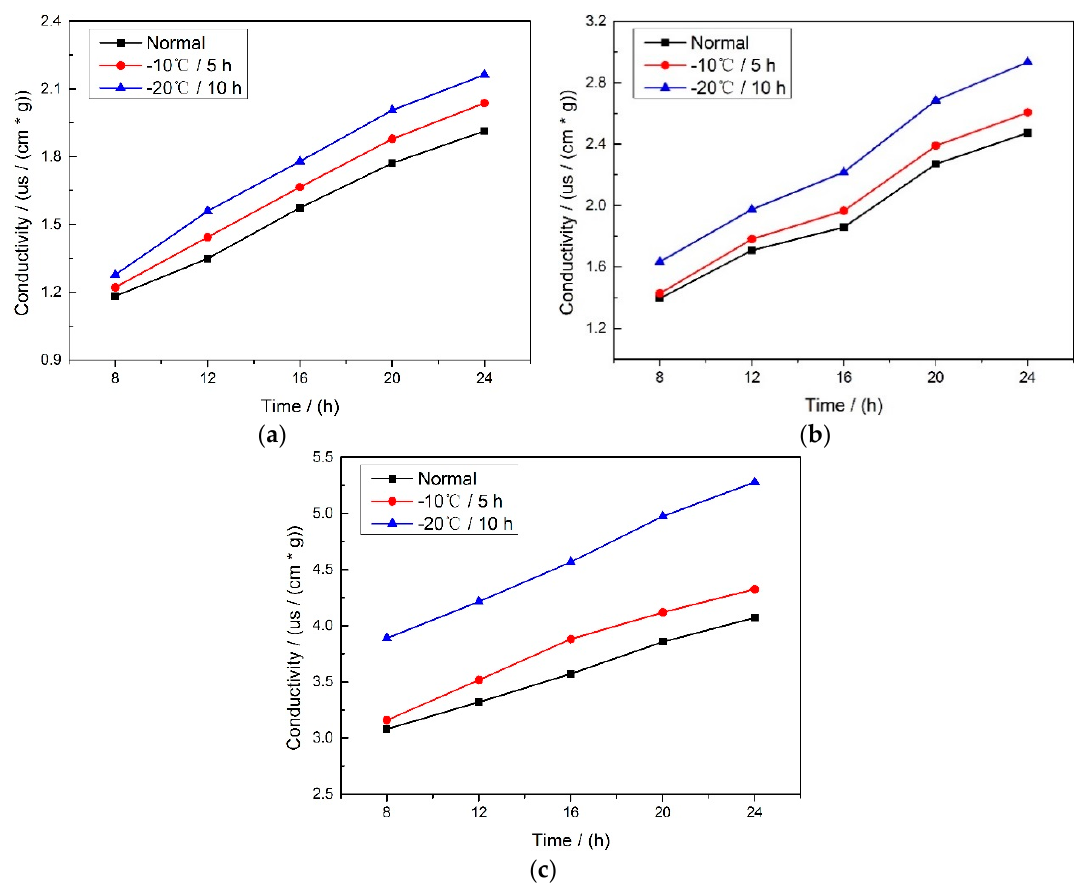
Figure 1. The conductivity of ( a ) Haoyu21, ( b ) Haihe78 and ( c ) Jindan10 soaking for 24 h.